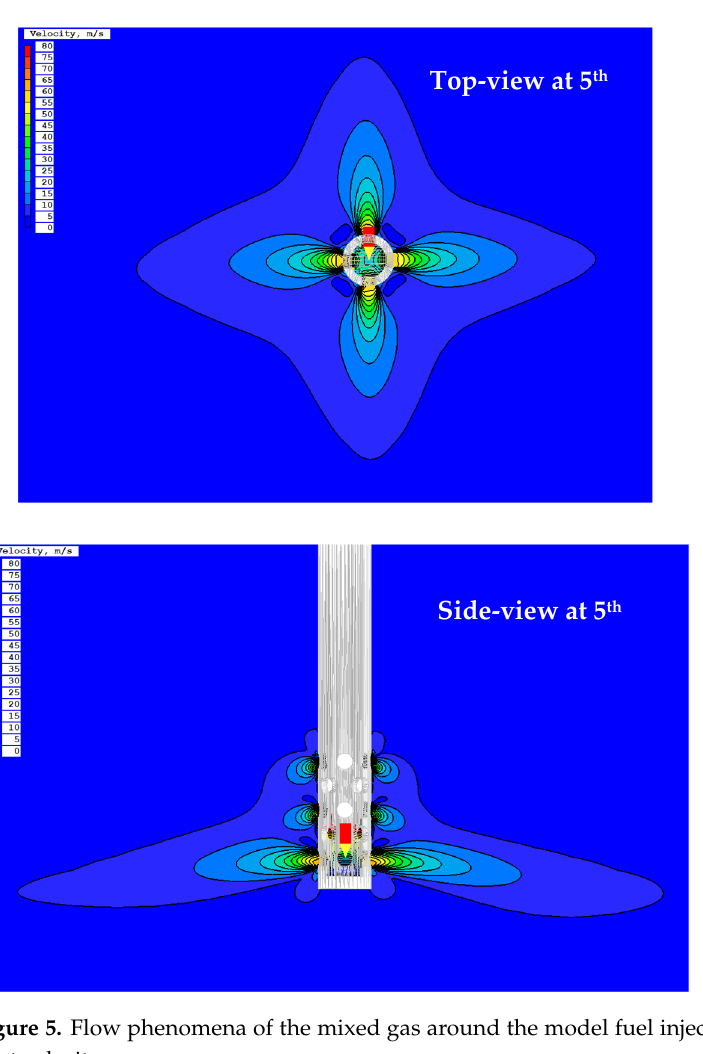
Figure 5. Flow phenomena of the mixed gas around the model fuel injector (Model 1) at 300 m/s inlet velocity.